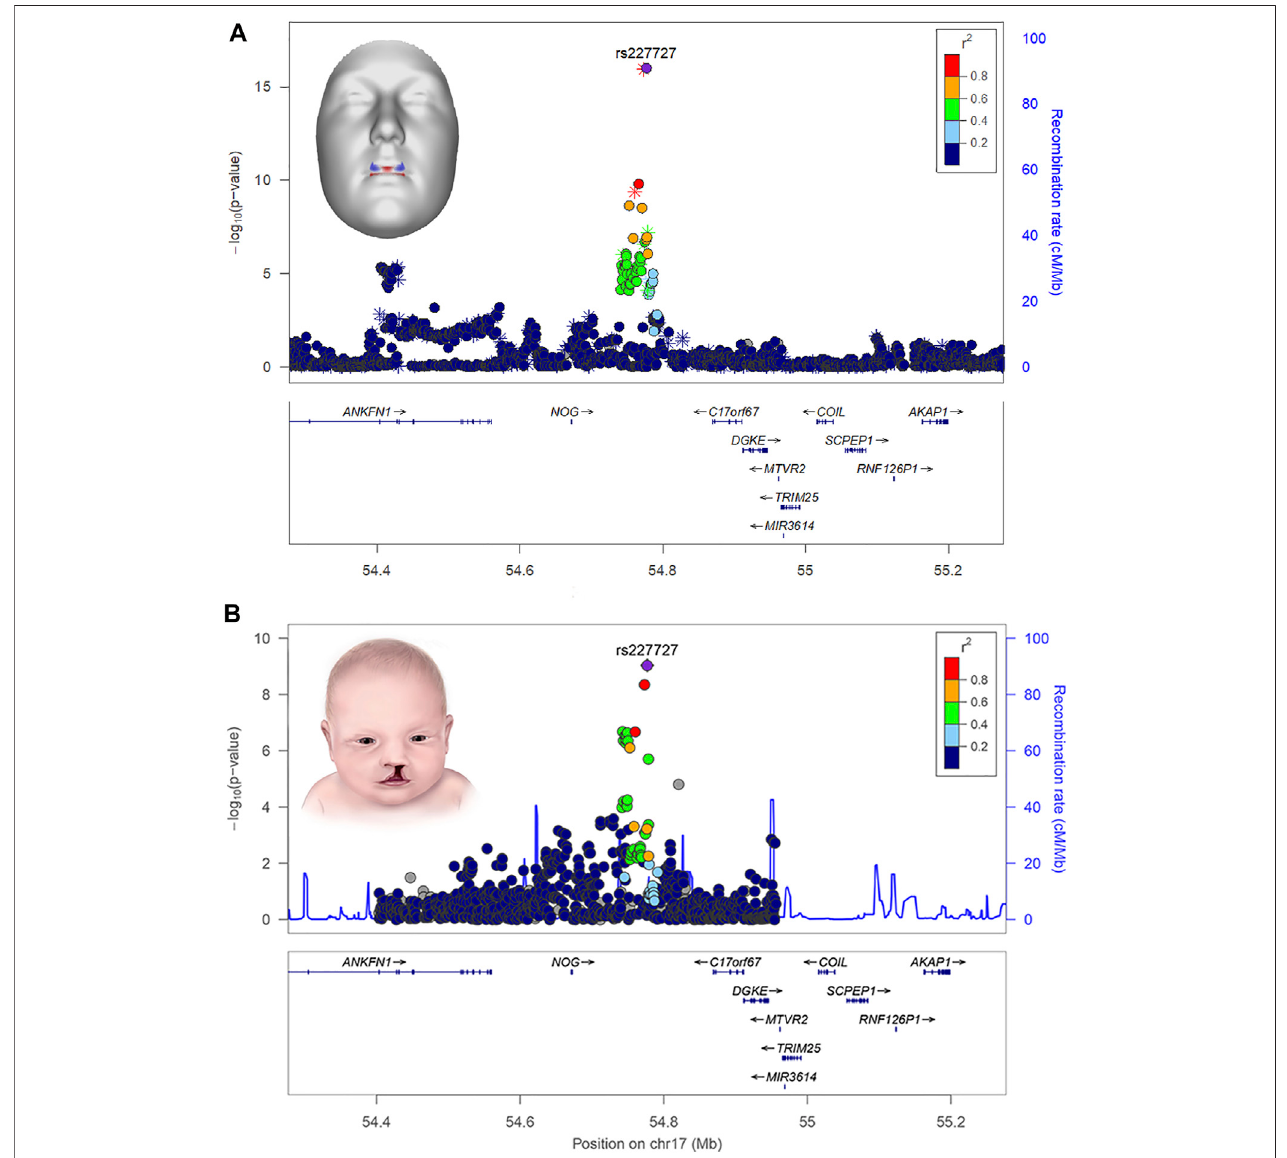
FIGURE 2 | LocusZoom plots showing the statistical association of SNP rs227727 near the gene NOG with lip shape (A) and nonsyndromic orofacial clefting (B) . The3DfaceinsetforpanelA(top)showstheeffectsoftheSNPascolor-codedheatmapwhereredindicatesregionsofthefacemovinginanoutwarddirectionandblue indicates regions of the face moving in an inward direction. The lip shape association was reported originally in White et al. (2021). The cleft association was reported originally in Leslie et al. (2015). Attribution: the inset for panel A (top) was adapted from White and Indencleef, Insights into the genetic architecture of the human face, viaFigshare, CCBY4.0, https://doi.org/10.6084/m9. fi gshare.c.4667261.v6.Theinsetforpanel B(bottom)isfromtheCentersforDiseaseControland Prevention and is available under the Creative Commons CC0 1.0 Universal Public Domain Dedication, via Wikimedia Commons, https://commons.wikimedia.org/wiki/File: